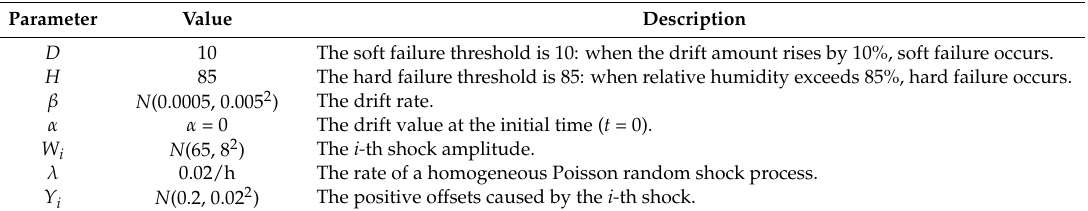
Table 2. Parameters of the reliability model for example I.